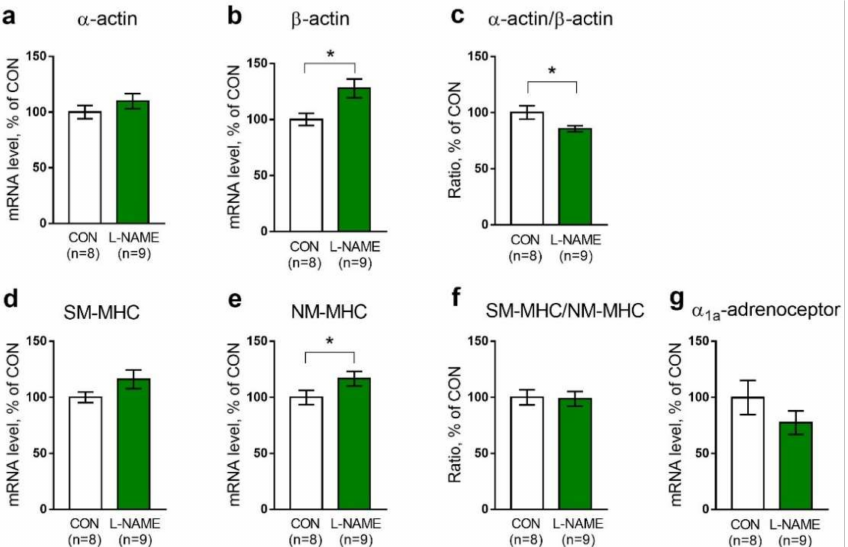
Figure 5. Relative mRNA levels of α -actin ( a ), β -actin ( b ), α -actin/ β -actin ratio ( c ), smooth muscle myosin heavy chain isoform (SM-MHC) ( d ), non-muscle myosin heavy chain isoform (NM-MHC) ( e ), SM-MHC/NM-MHC ratio ( f ) and α 1a -adrenoceptor ( g ) in the saphenous artery of control (CON) or L-NAME offspring. Data are presented as the mean ± S.E.M., n , number of animals. * p < 0.05 (unpaired Student’s t -test). Data are normalized to the mRNA content of RPLP0 in the same tissue sample; the mean value in the control group was taken as